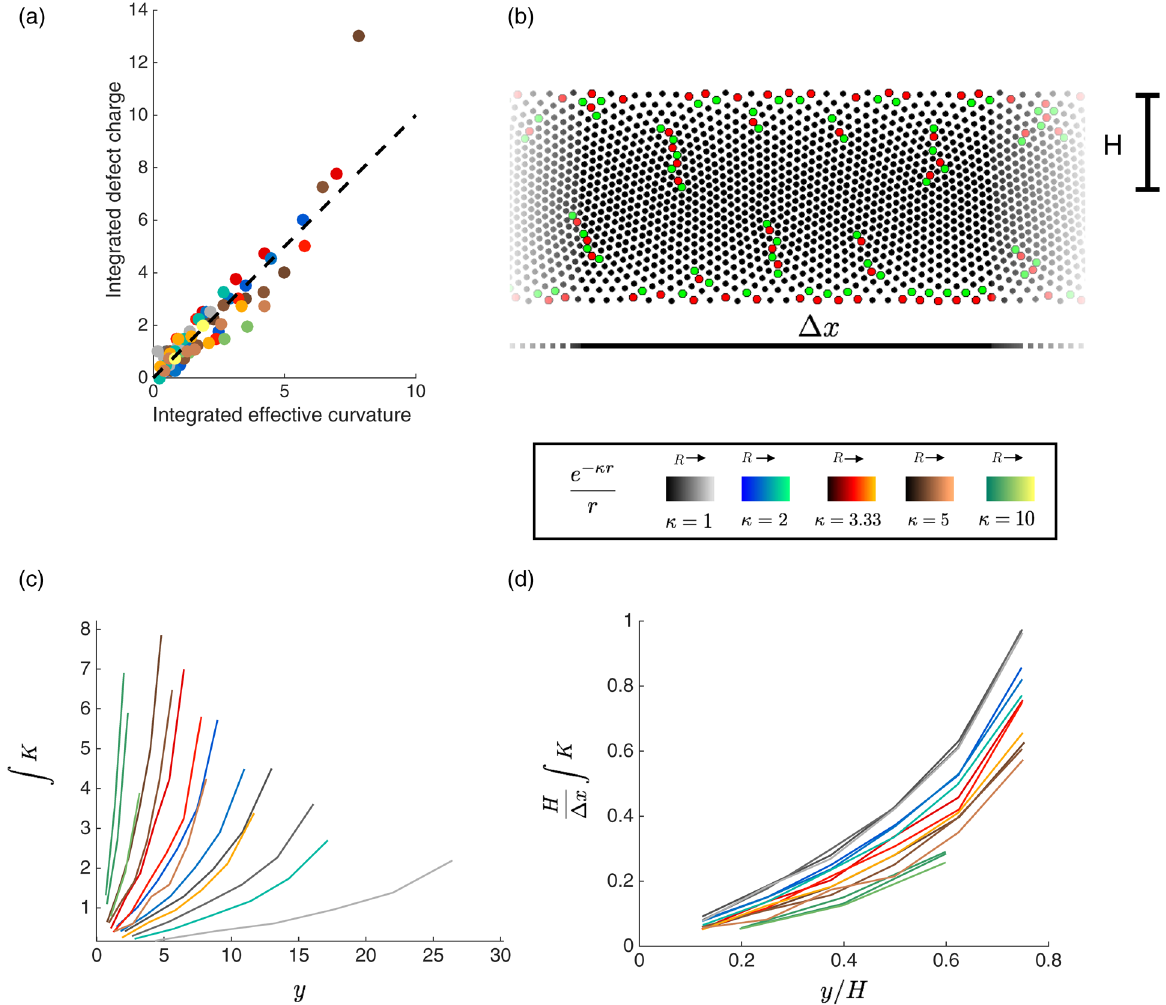
γ y 2 . (a) Integrated effective curvature predicts final FIG. 11. Yukawa interacting particles in a parabolic confining potential V ext ¼ defect distribution as in the case for pure power-law potentials. (b) Example particle configuration. (c, d) Scaling behavior of the integrated curvature profiles. With the additional length scale introduced by the screening length, our data suggest that the integrated curvature profiles no longer collapse when scaling the coordinates by the system size as shown in